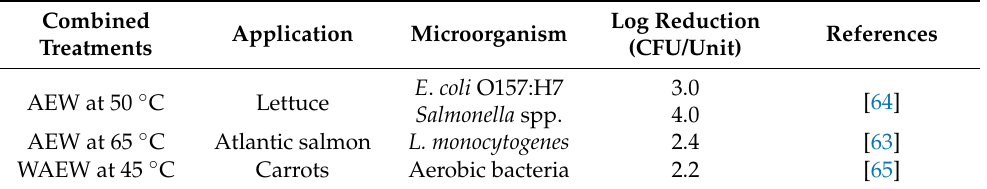
Table 5. Combinations of AEW and WAEW with thermal